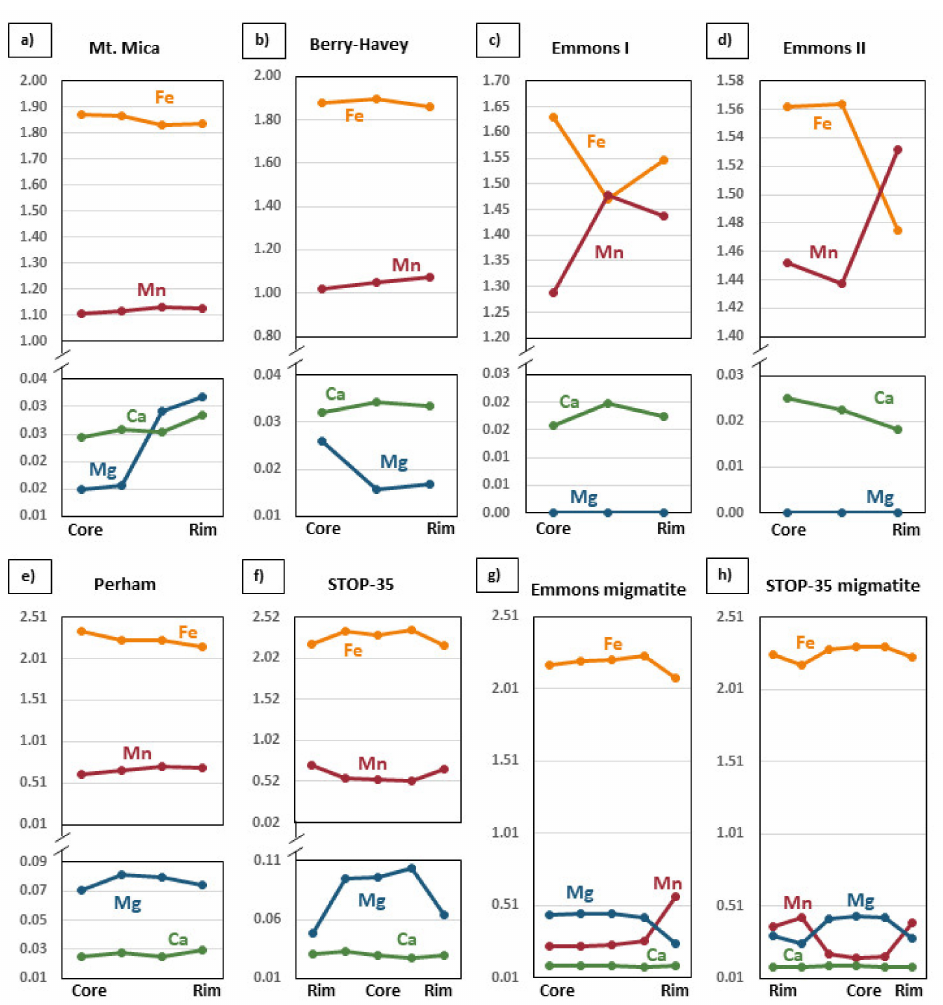
Figure 10. Major element variations across garnet crystals from the studied pegmatites ( a – f ) and migmatites ( g , h ). Values in cations (apfu).